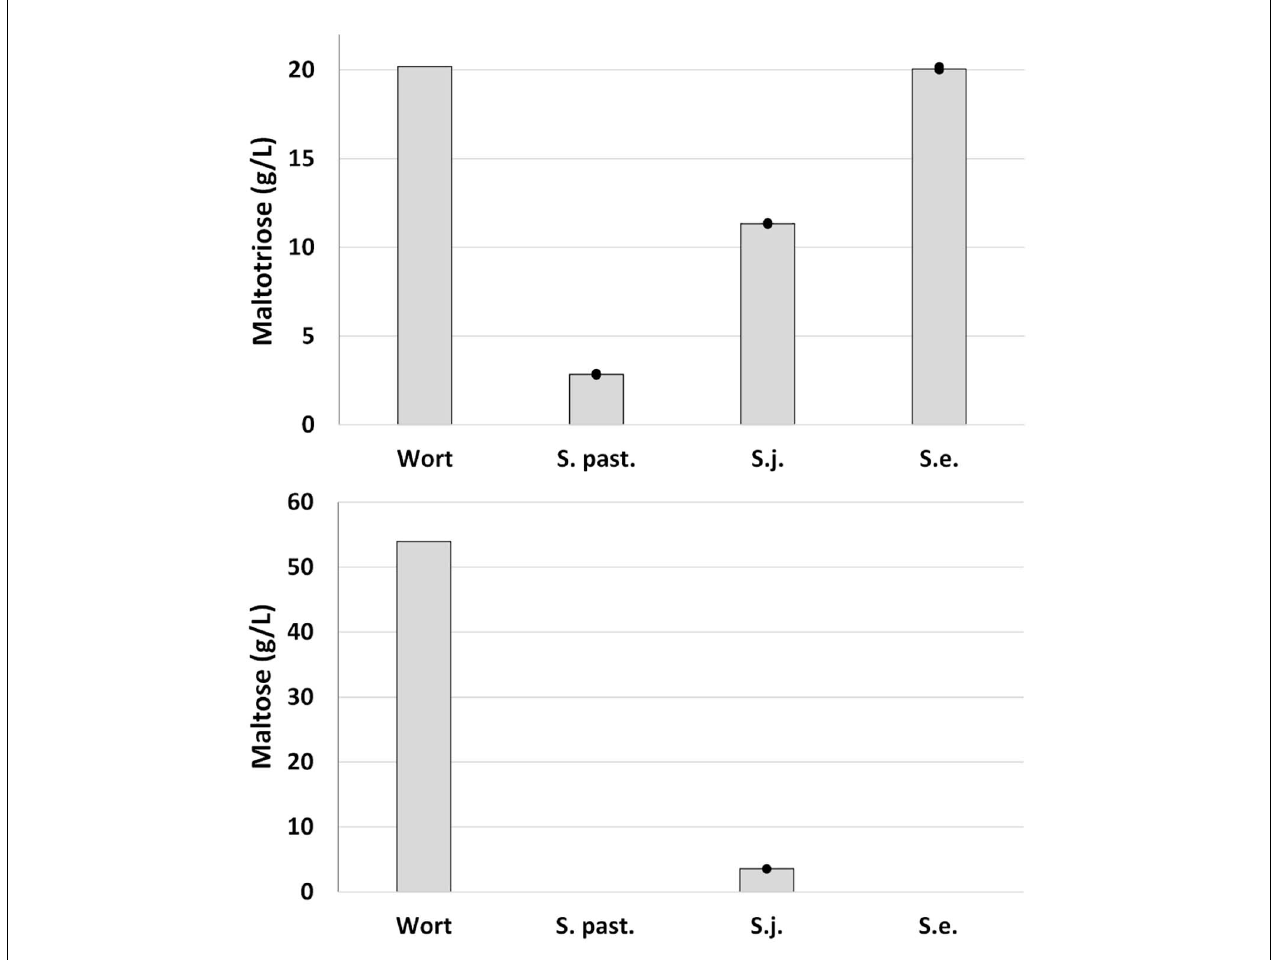
FIGURE 4 | Maltose and Maltotriose concentrations in all-malt 12 ◦ P wort, and beer after fermentation at 15 ◦ C for up to 39 days. Strains include one lager reference strain (TUM 34/70), as well as the German strain of S . jurei (TUM 629), and the type strain of S . eubayanus (C902). Dots represent the individual fermentations and bars show the mean of the